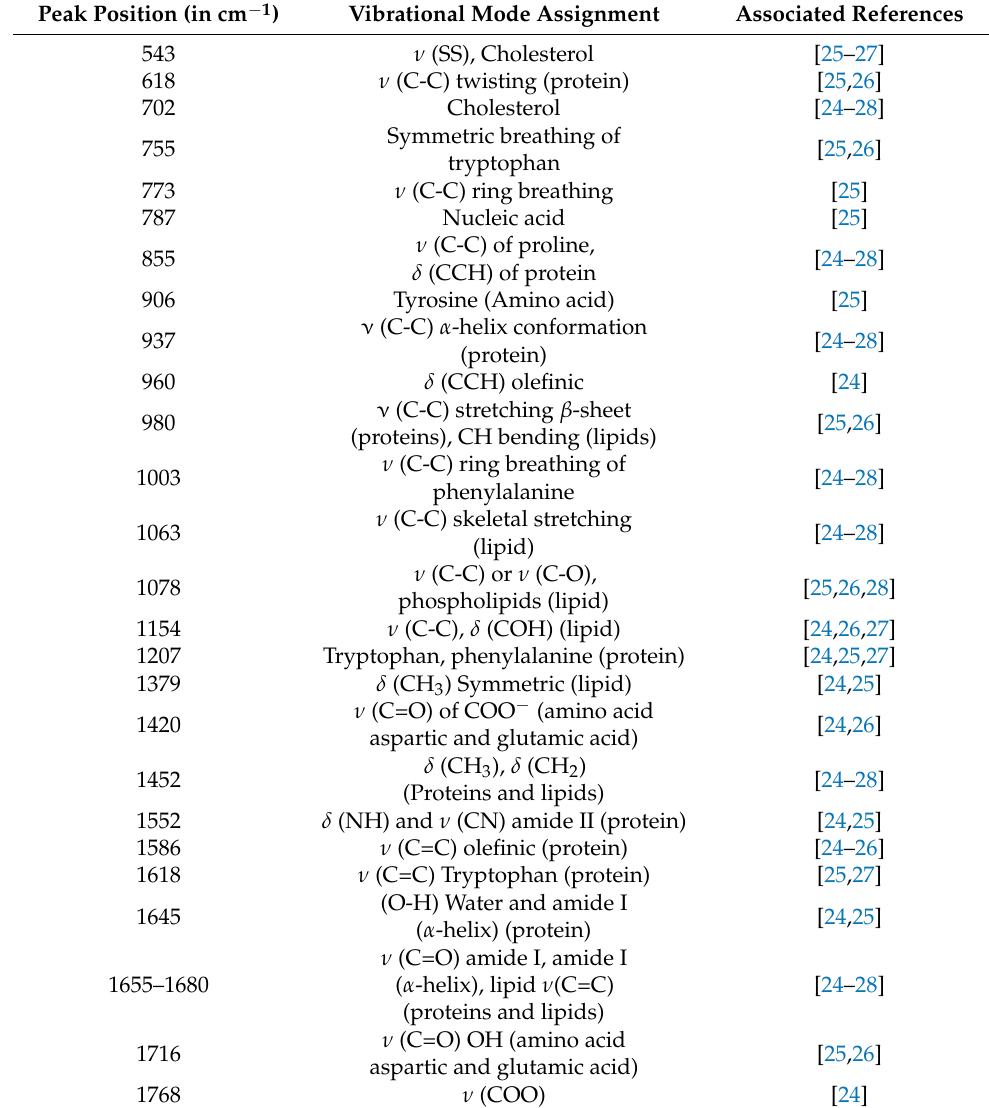
Table 3. Assignment of most prominent Raman wavenumbers and bands deduced from VIP score depicting difference between healthy and eczema skin. ν = stretch, δ =